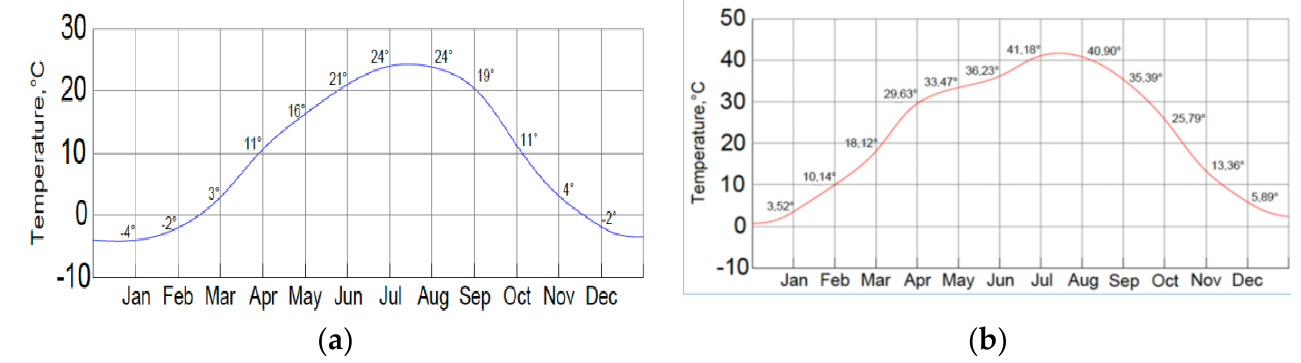
Figure 6. Graph of changes in concrete surface temperature, taking into account the ambient tem- perature: ( a ) Without the influence of solar radiation; ( b ) Taking into account the influence of solar radiation.